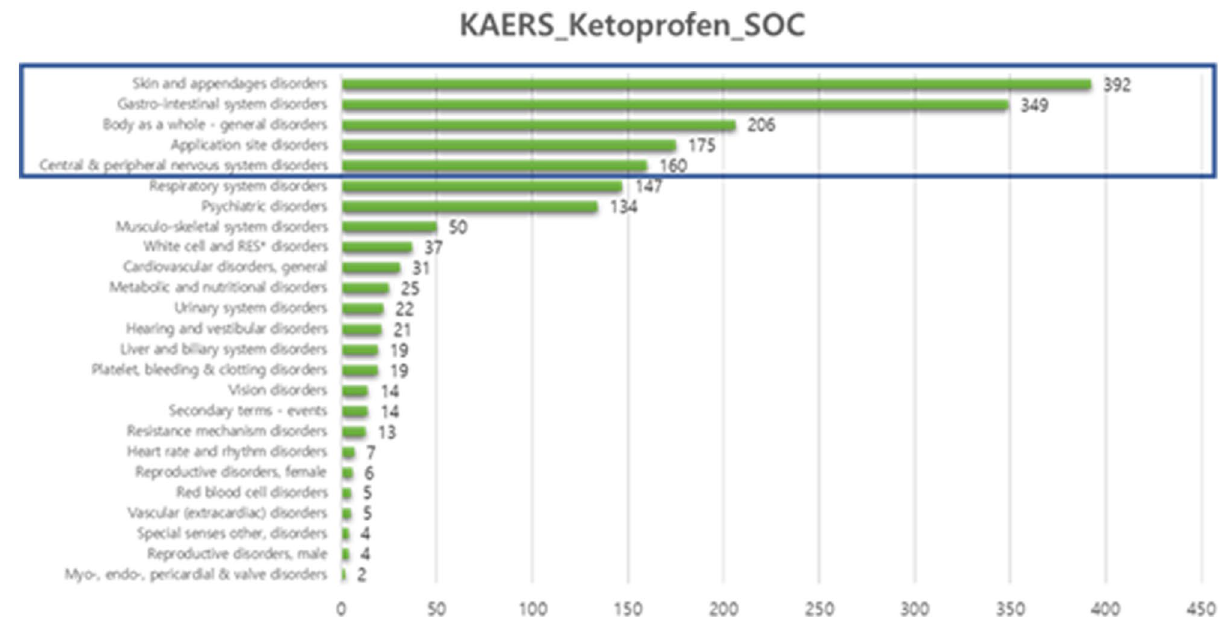
Figure 6. SOC ranking graph for KAERS-based ketoprofen adverse event